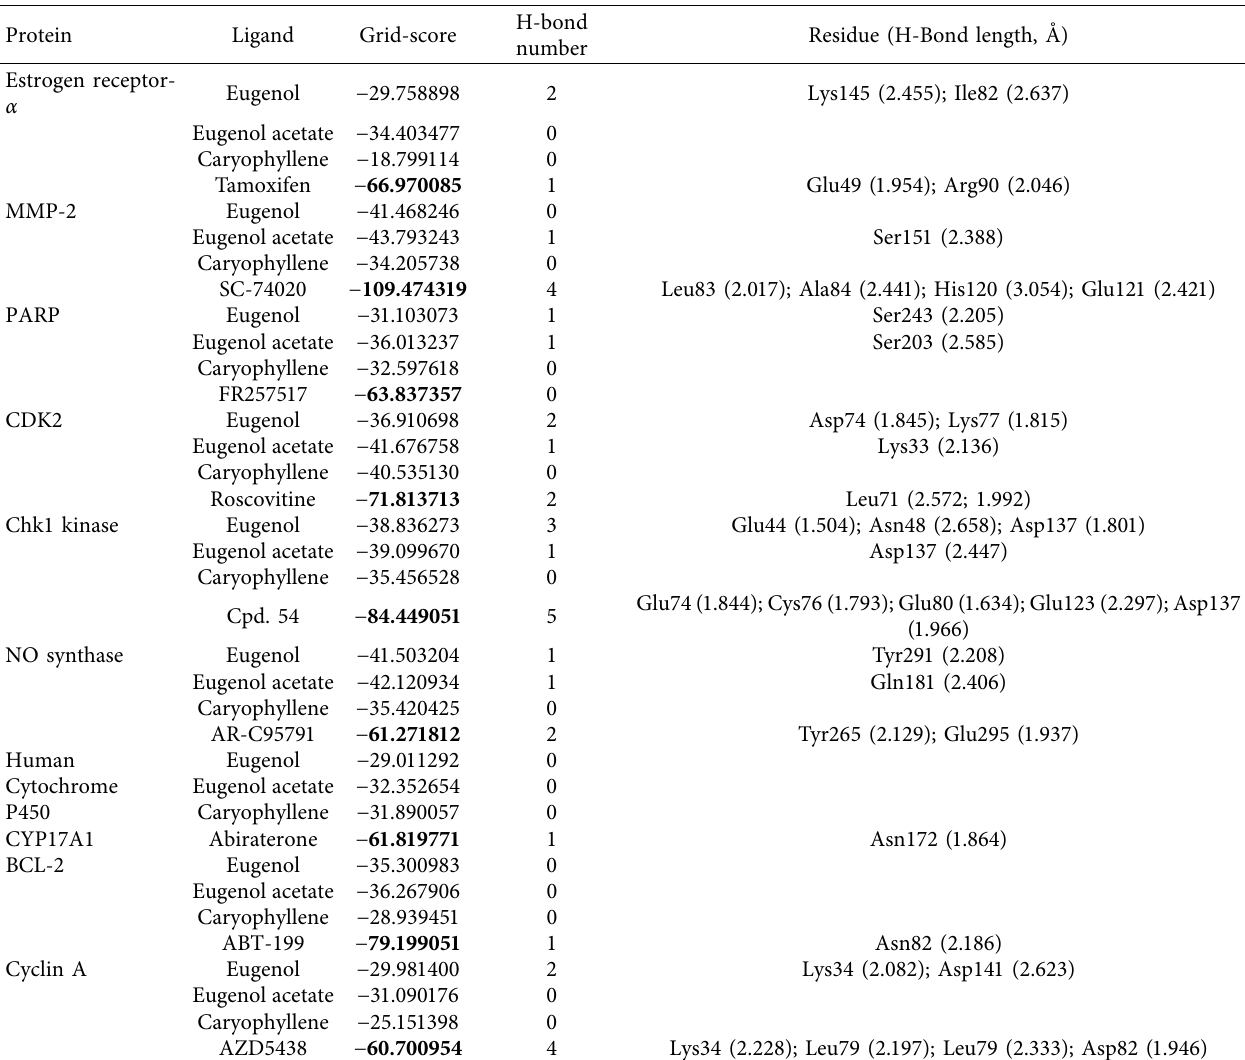
Table 2: Grid-score results and hydrogen bond